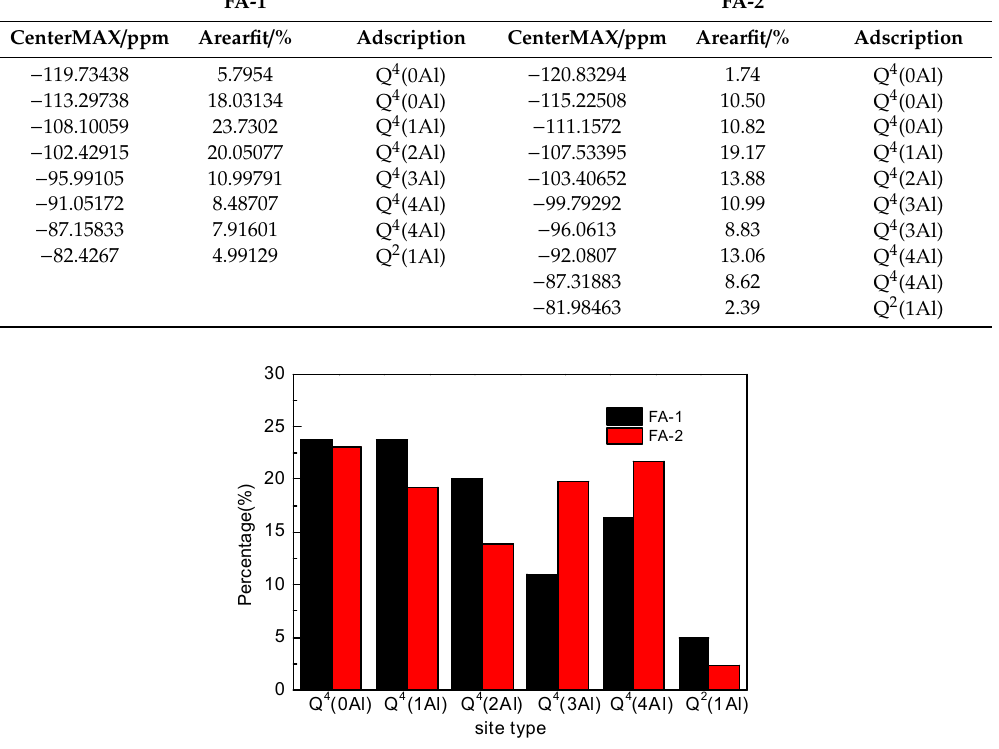
Figure 8. Comparison of the silicate compositions for FA-1 and FA-2.